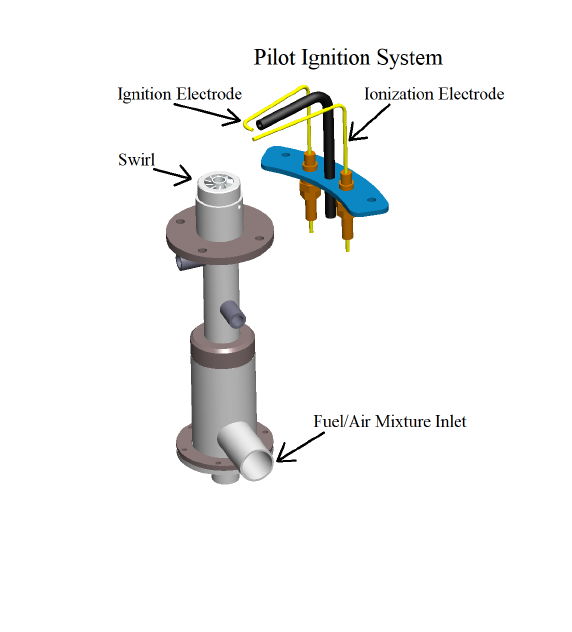
Figure 1: Solid model of the